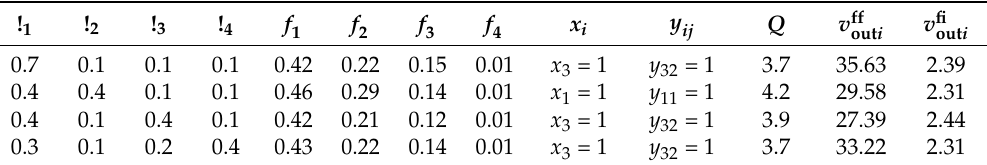
Table 7. Optimal decision results under different weight conditions (variable unit in the table is the same as that in this